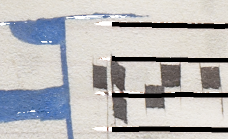
( a ) Spurious marks left by the object detection algorithm.